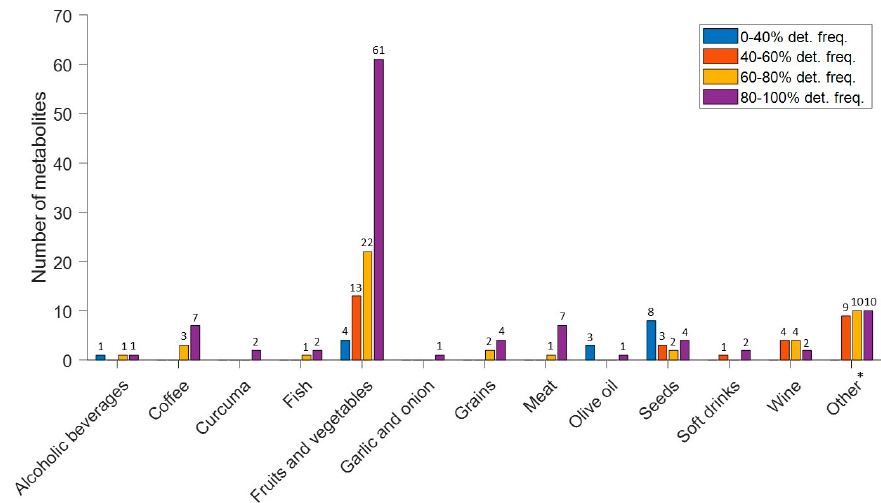
Figure 3. Number of metabolites and detection frequencies of the semi-quantitative analysis. Note: (*) Potato, cocoa, mushrooms, legumes and nuts.